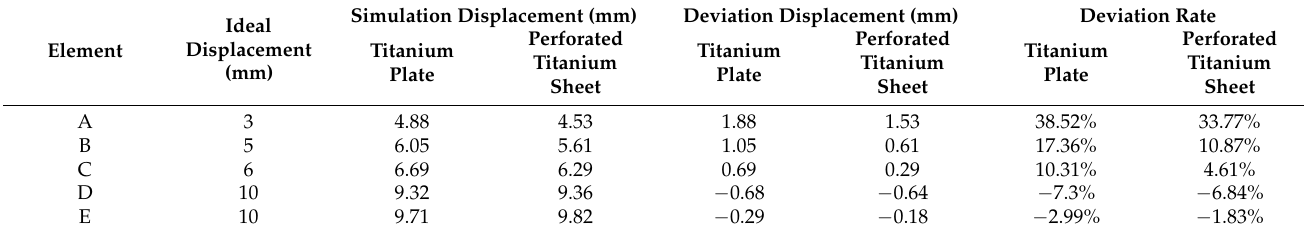
Table 3. Titanium plate and perforated titanium sheet displacement